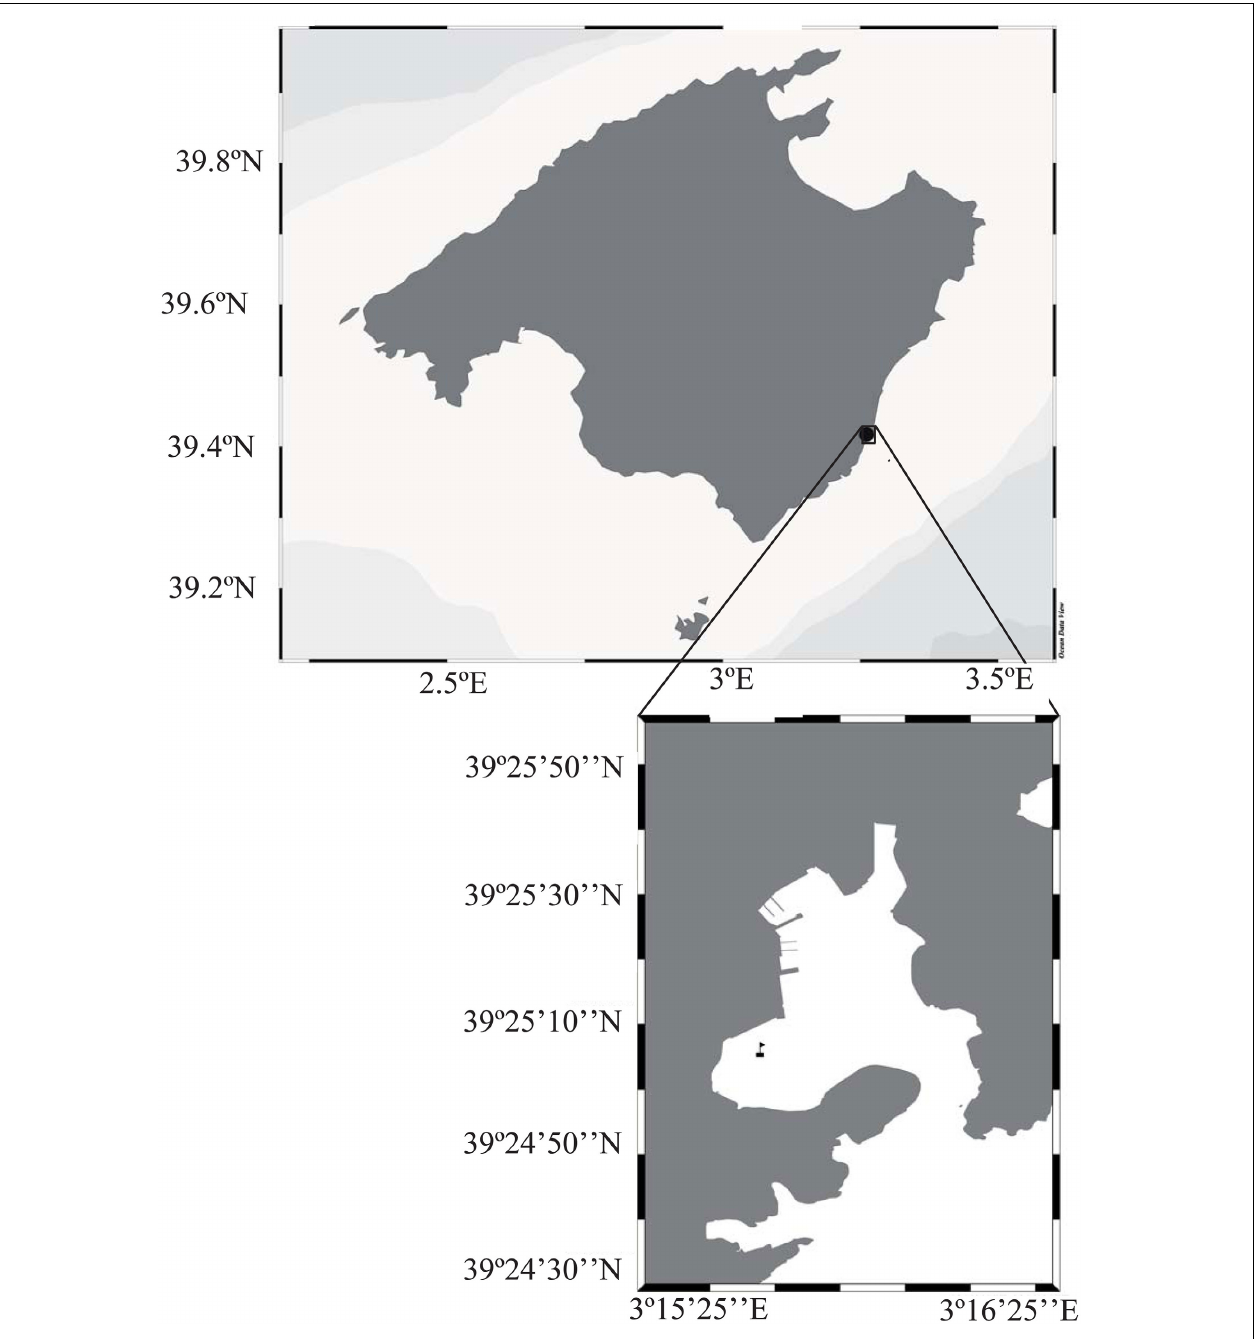
FIGURE 1 | Map of the island of Majorca in the Mediterranean Sea, with the inset showing the Bay of Portocolom with the sampling site marked by a